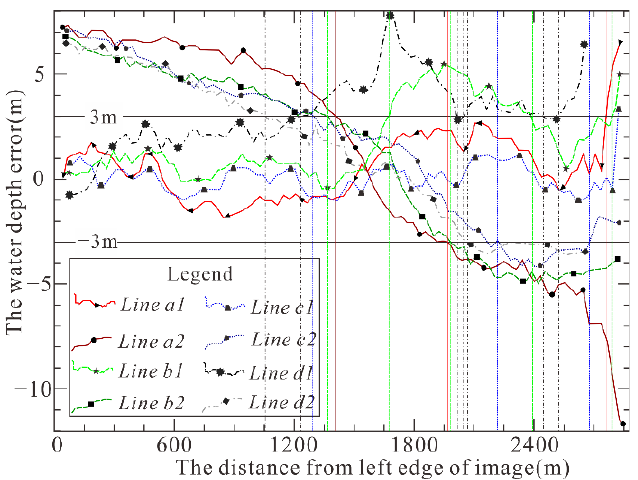
Figure 9. a , b , c , and d are the Line a , Line b , Line c , and Line d check line (Ref Figure 4); 1 and 2 are the retrieved water depth error between our model, traditional model, and reference data